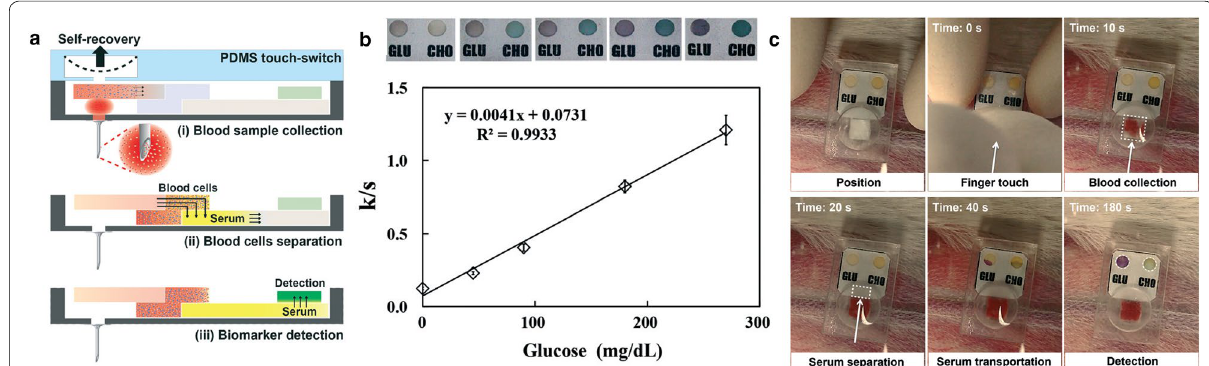
Fig. 3 a The sampling and measurement process of blood using a hollow MN and paper-based sensor. b The change of color (above) and calibration curves for glucose measurement (below). c A series of optical images of the blood sampling and glucose measurement in a rabbit ear with the integrated hollow MN and the paper-based sensor (Reproduced with permission [89]. Copyright 2015, the Royal Society of